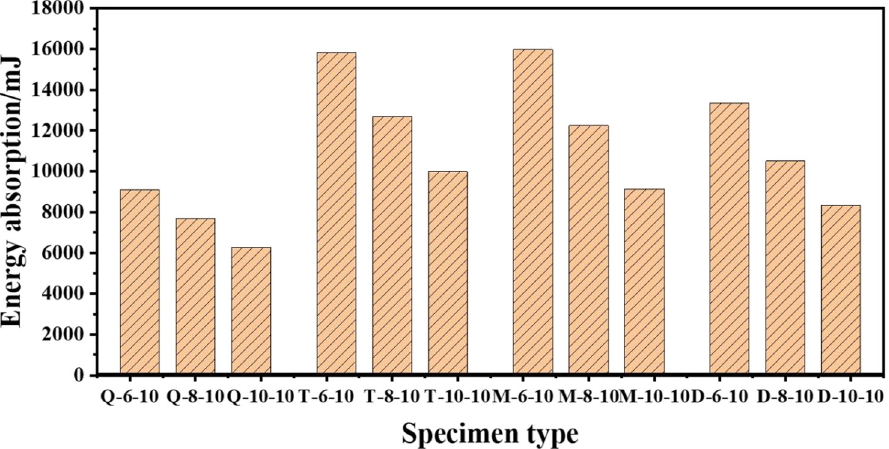
Figure 7: Energy absorption of di ff erent specimen